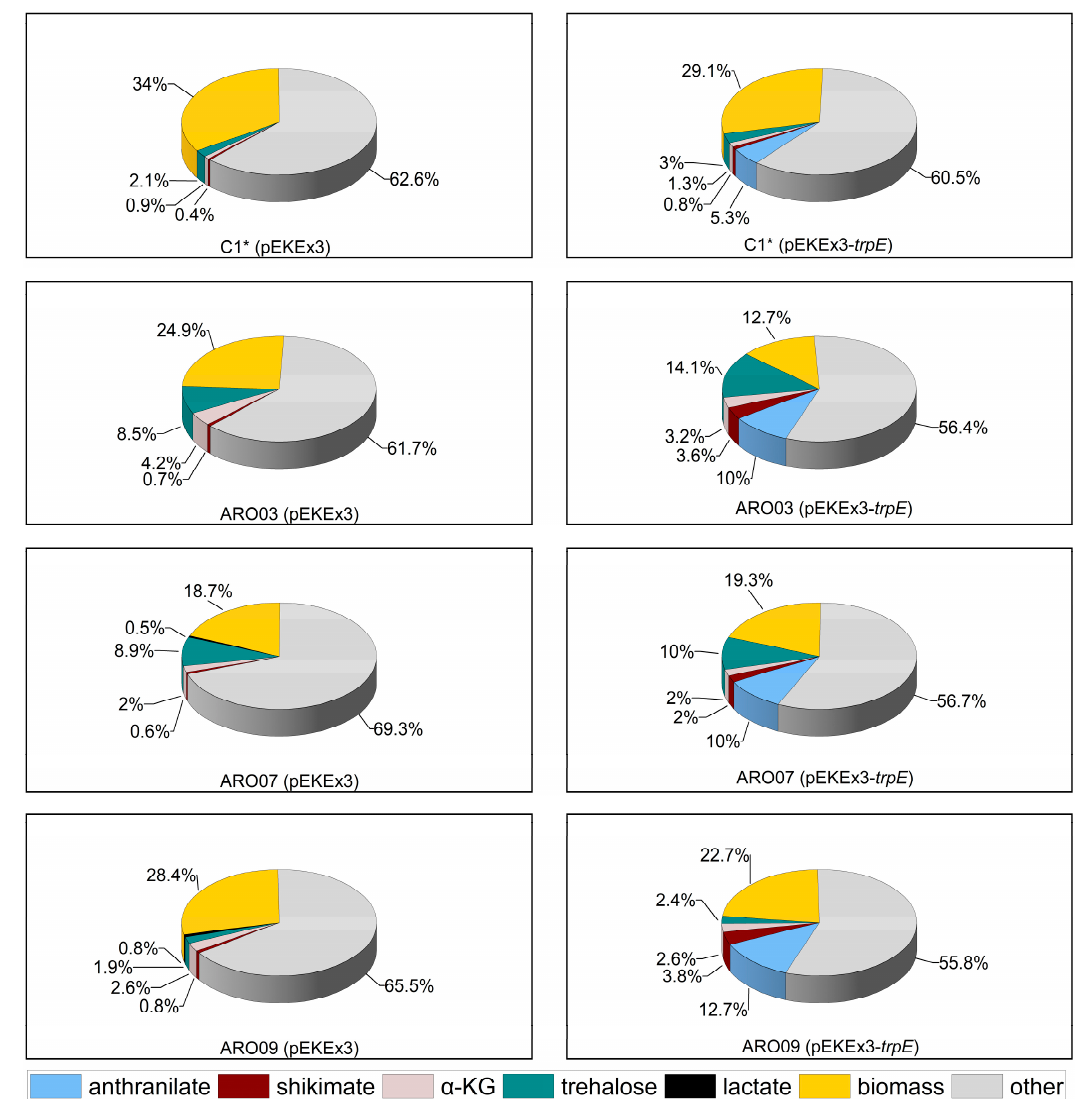
Figure 4. Fate of carbon from glucose in cultivations of C. glutamicum ARO strains carrying the empty vector (left) or pEKEx3- trpE FBR (right). Carbon (given in mol%) derived from glucose found after 48 h in secreted products anthranilate (blue), shikimate (maroon), α -ketoglutarate (light red), trehalose (green), lactate (black) as well as in the formed biomass (yellow) are shown for C. glutamicum strains C1*, ARO03, ARO07, and ARO09 harboring either pEKEx3 (left) or pEKEx3- trpE FBRfbr (right). Carbon that could not be accounted for is depicted in gray (other). Values were determined from duplicate cultures. Experimental error was less than 20%. Abbreviations used: α -KG, α -ketoglutarate. Carbon distribution of all ARO strains can be found in the supplementary data (Figure S1; Figure S2).